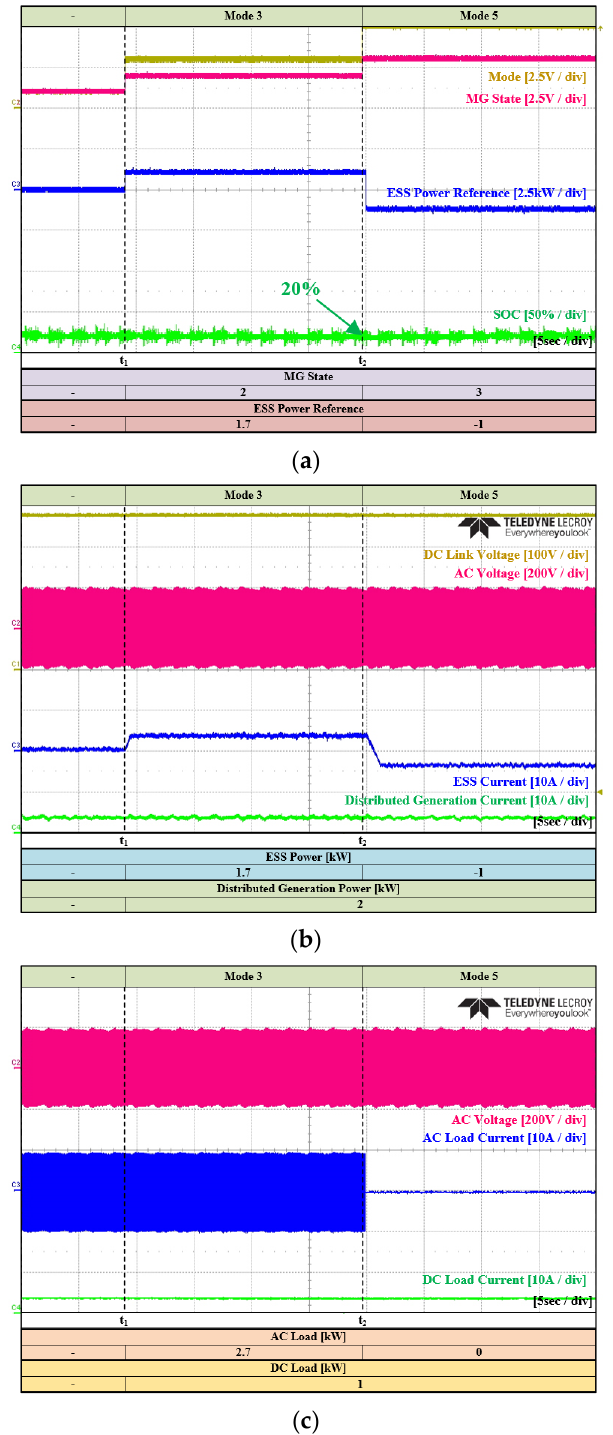
Figure 25. Experimental waveforms of standalone Modes 3 and 5. ( a ). Waveforms of the input data (MG state, SOC) and output data (Mode, ESS power reference) of the ANN. ( b ) Waveforms of DC link and AC voltage, ESS, and DG current. ( c ) Waveforms of each load current and AC grid voltage.